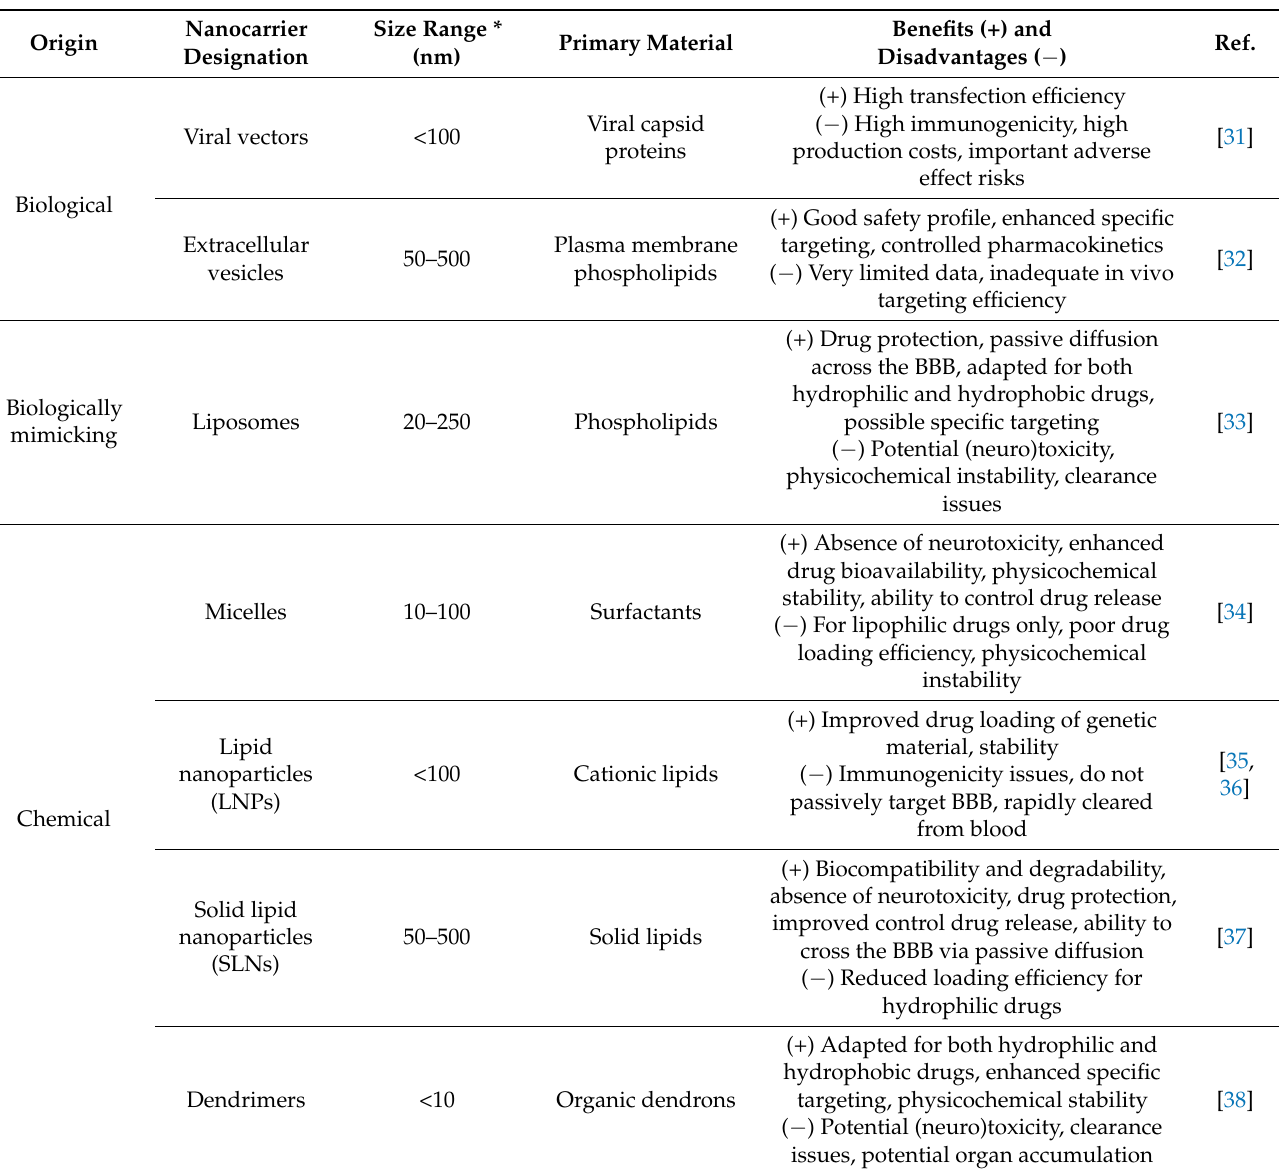
Table 1. Nanocarriers currently developed for the treatment of CNS-related